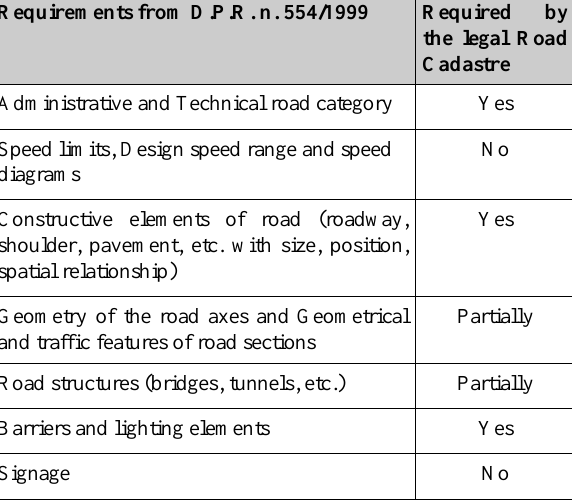
Table 2. Requirements from D.P.R. n.